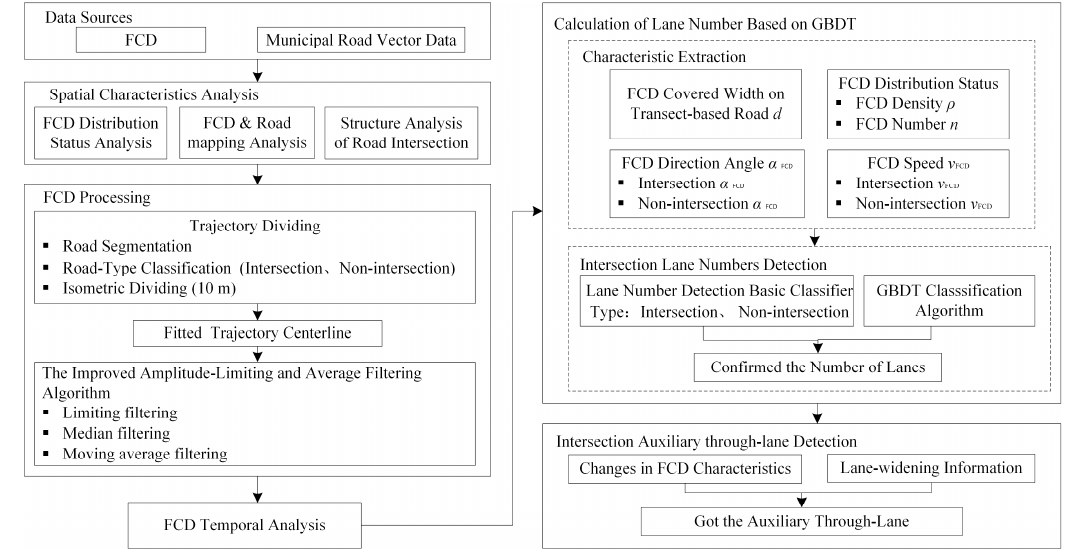
Figure 1. The technical process of detection method. FCD: floating car data; GBDT: gradient-boosted decision tree.